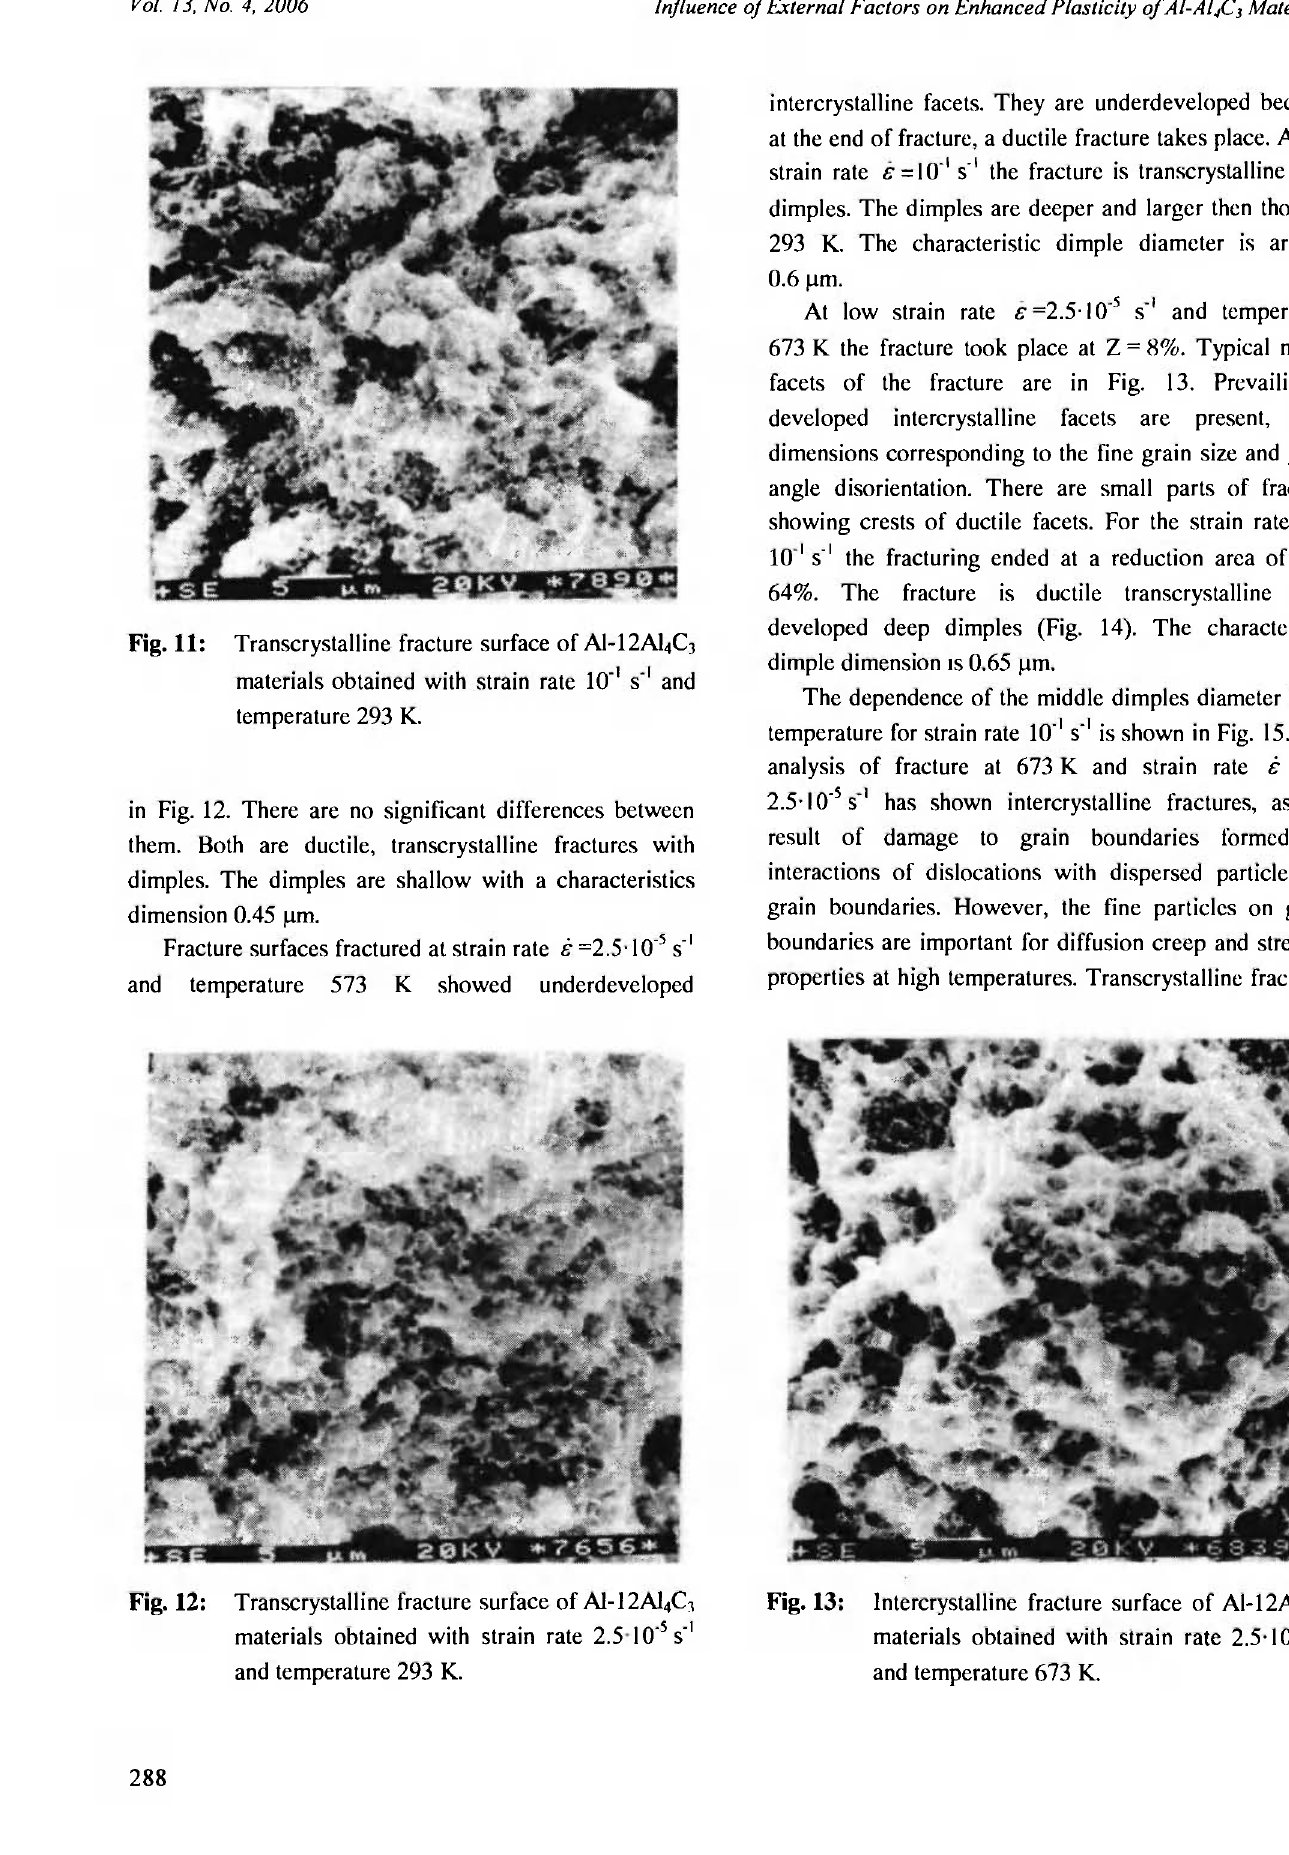
Fig. 13: Intercrystalline fracture surface of A1-12A1 4 C 3 materials obtained with strain rate 2.5-10 's" 1 and temperature 673